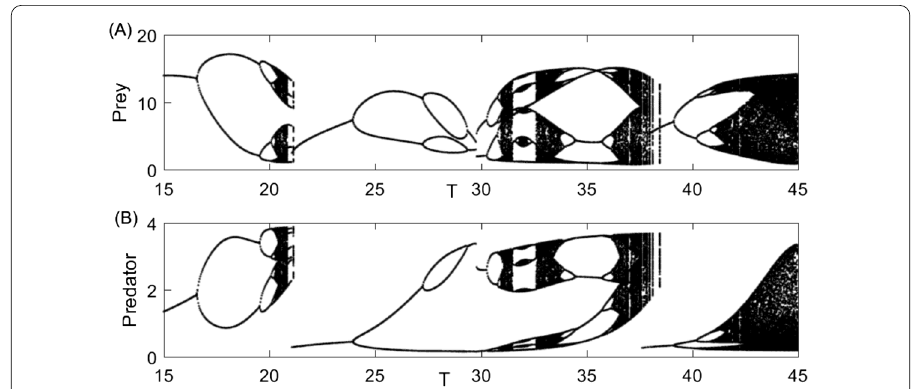
Figure 4 Bifurcation diagrams of model (17) with respect to bifurcation parameter T . Parameter values are: r = 0.69, k = 20, α = 0.65, C = 0.37, ω = 0.15, D = 0.62, δ = 0.4, h = 0.17, λ 1 = 0.65, λ 2 = 1.2, θ = 0.75